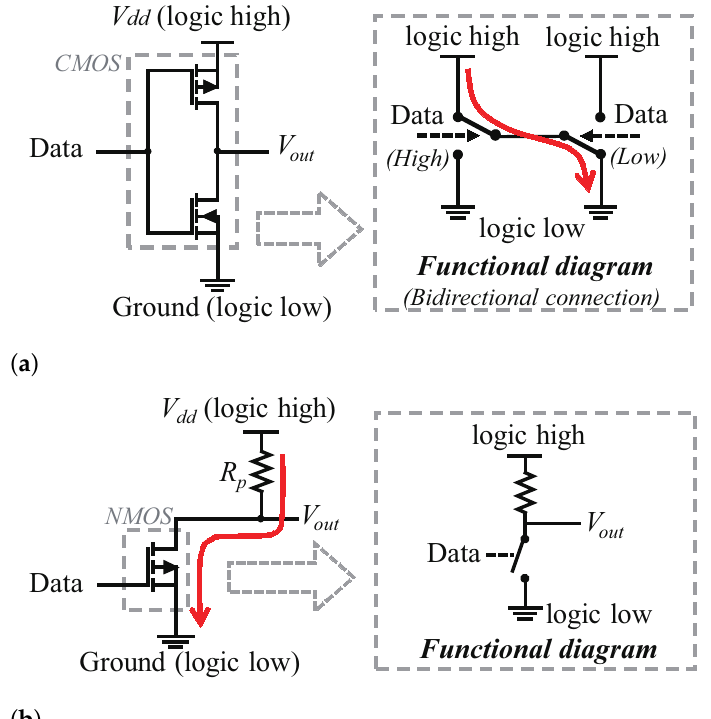
Figure 2. Push–pull and open-drain architectures. ( a ) The push-pull architecture. The CMOS act as a single-pole double-throw switch to connect the V out to either V dd or ground. When two push–pull outputs are connected, it is possible to cause a short circuit if one of the outputs is high and the other is low. ( b ) The open-drain architecture. The NMOS transistor acts as a switch. The leakage current (red solid arrow) occurs when the switch is closed and V out is logic